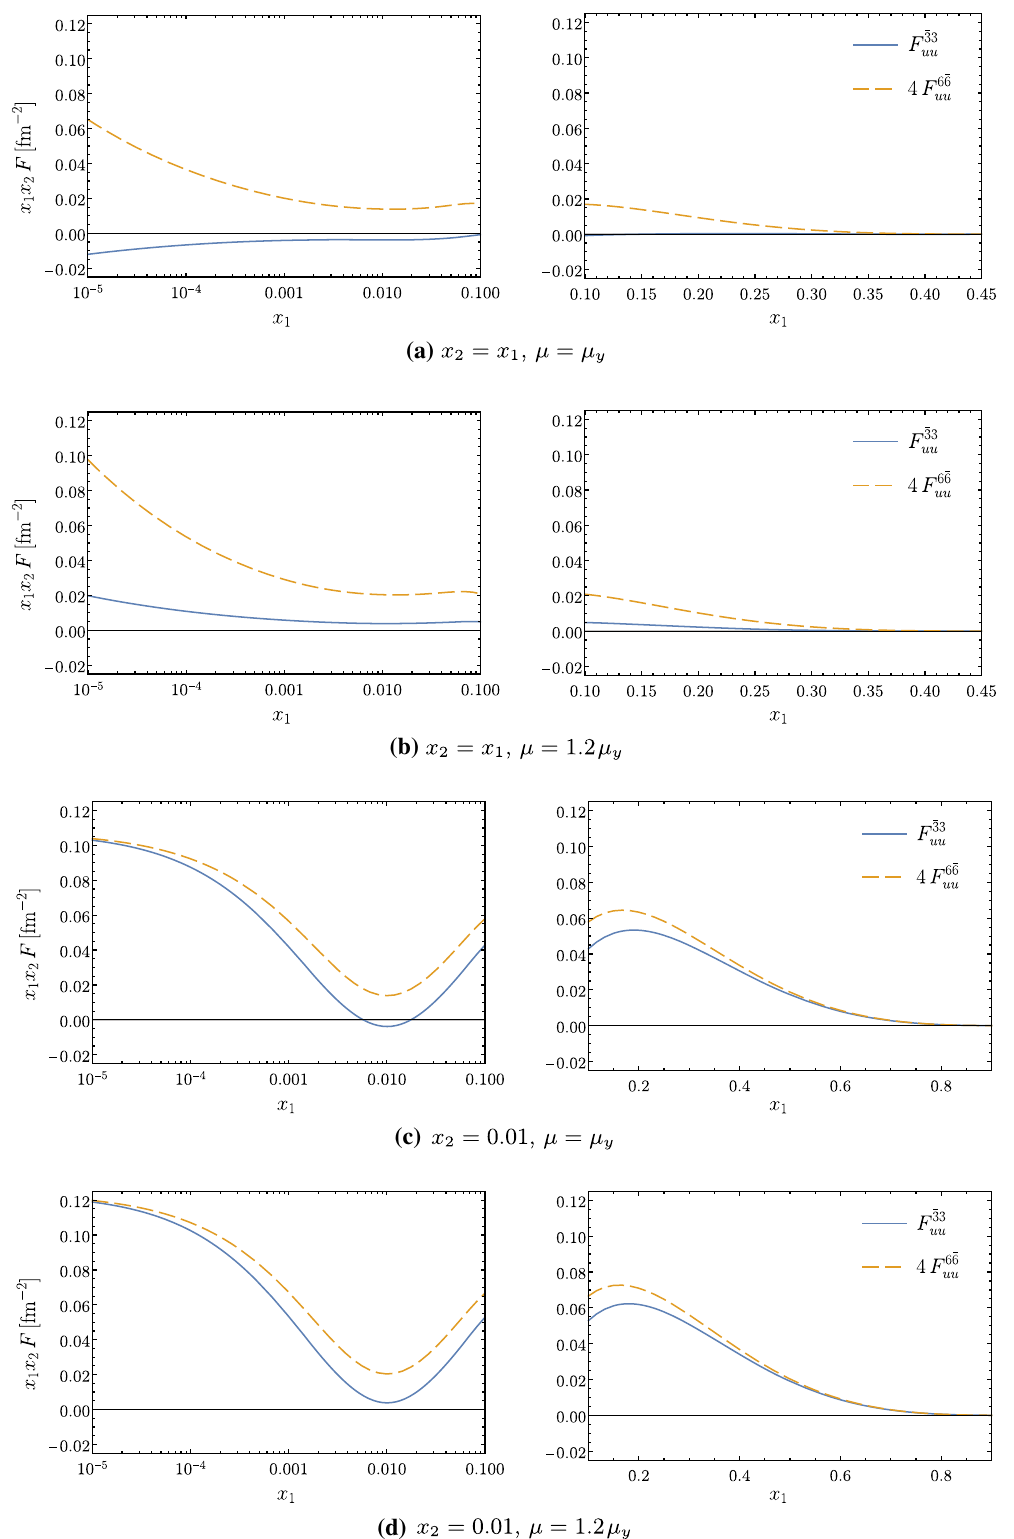
Fig. 9 The distributions F 33 uu and F 66 uu computed with the two-loop splitting formula for μ y = 10GeV. Note that the two values of μ are not the same as in Fig.